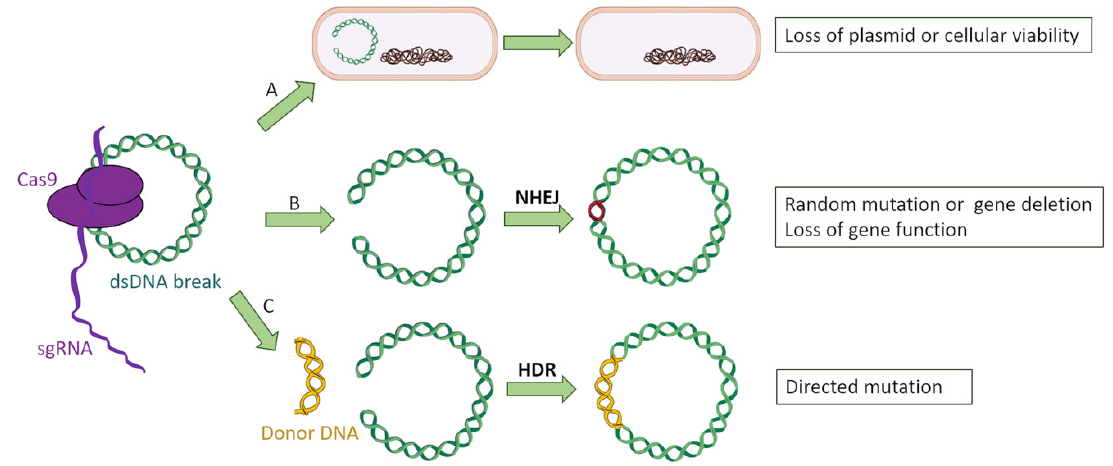
Figure 4. Three possible events after CRISPR-Cas9 targeting of bacterial genes: ( A ) The double-strand break affecting a plasmid leads to its loss, whereas a double break into the bacterial chromosome is lethal for the microorganism. ( B ) The bacterium attempts to fix the double-strand break by nonhomologous end joining (NHEJ), introducing random mutations into the targeted gene which causes a loss of function. ( C ) The bacterium uses a donor DNA fragment designed with the desired mutations to repair the double-strand break, incorporating those mutations.